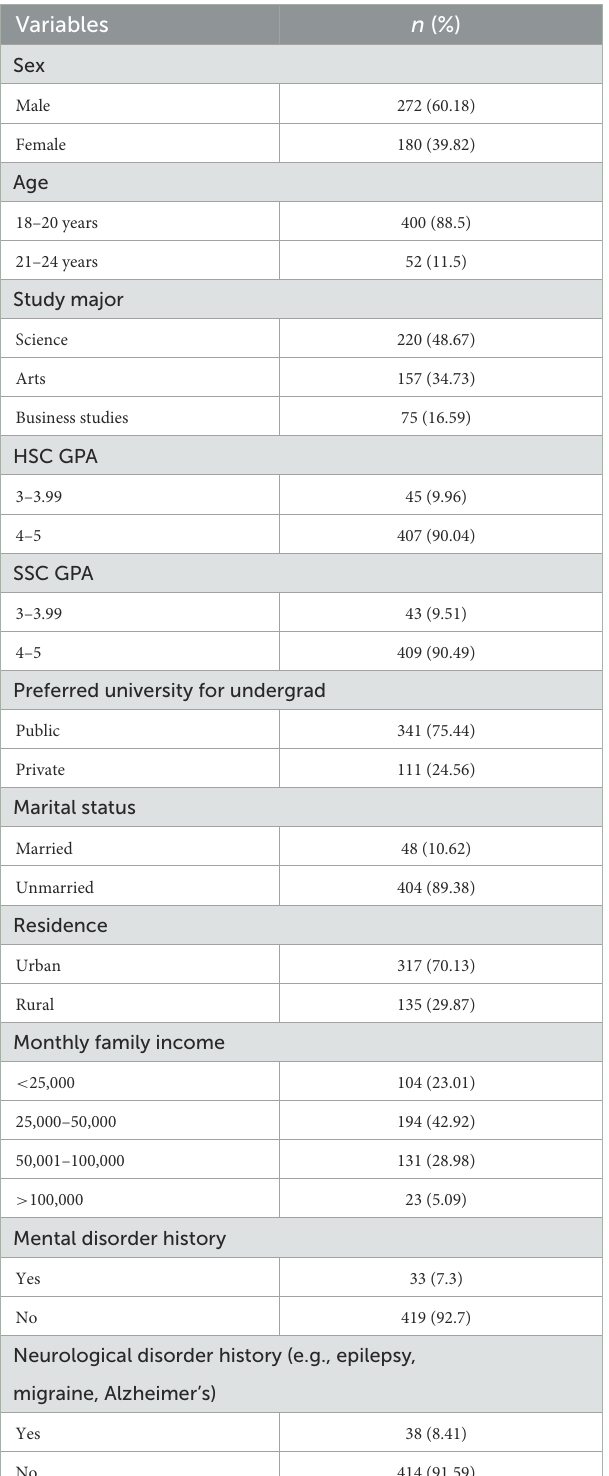
TABLE 1 General characteristics of the participants ( N =